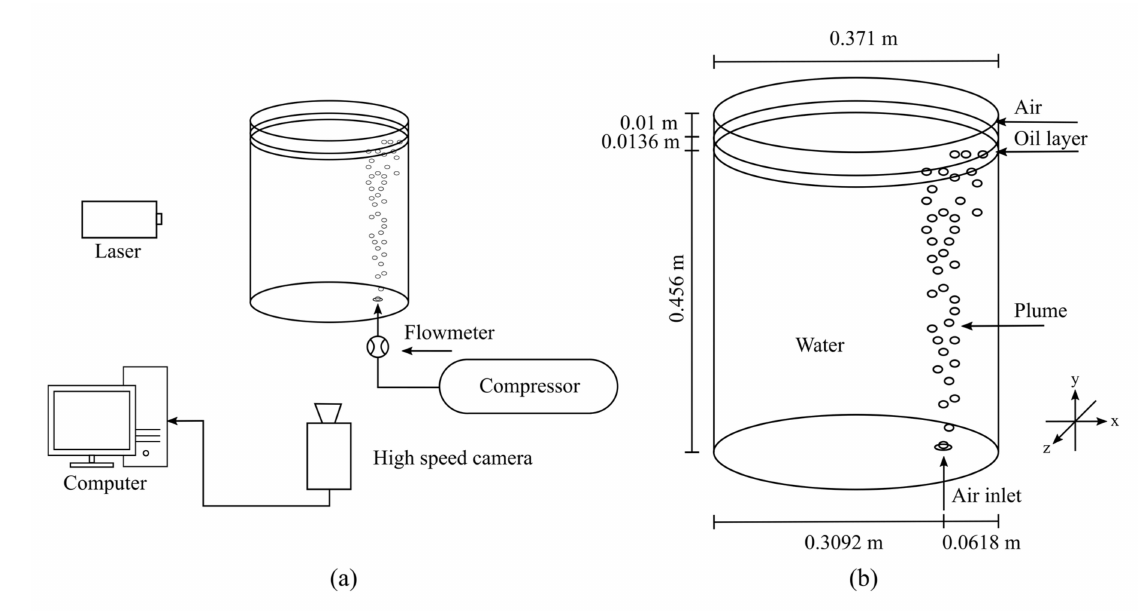
Figure 1. ( a ) Experimental setup and ( b ) scale model dimensions. Table 1. Material properties and parameters used in numerical